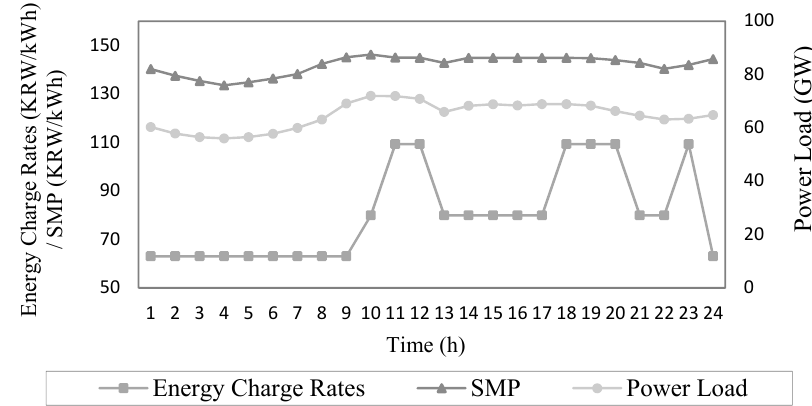
Figure 1. Pattern comparison of energy charge rates, SMP, and entire power load (average figure of January 2015).